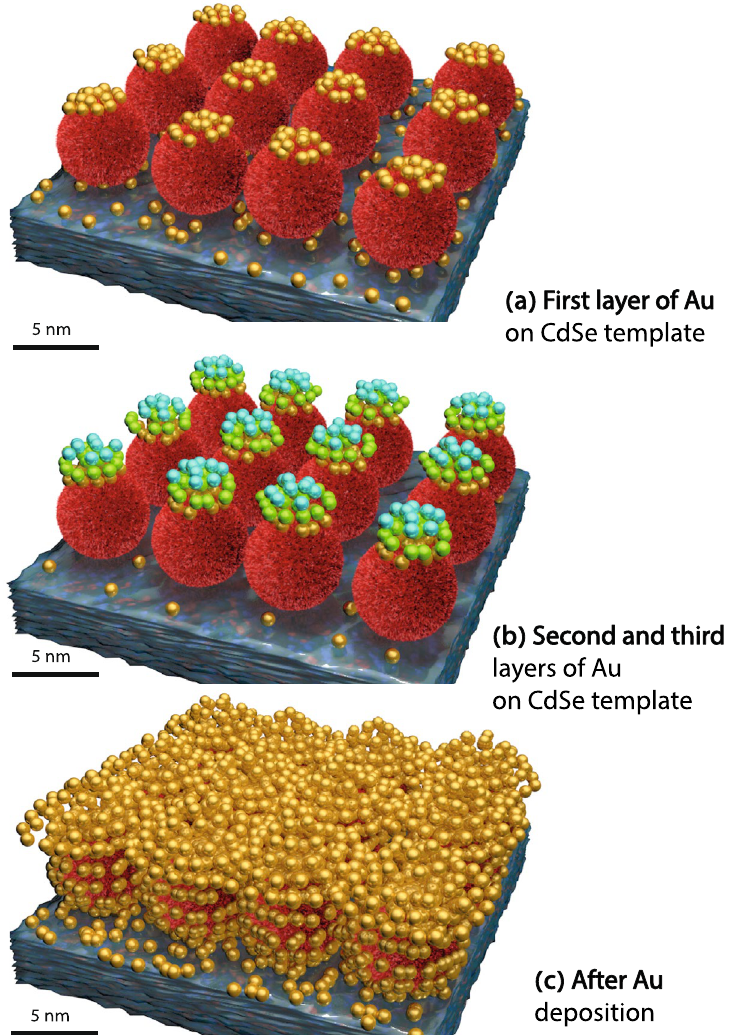
Figure 8. Diagrammatic sketch of Au nanostructure growth on QD arrays template depicting the case of dithiol , in particular: ( a ) template-mediated nucleation of Au on top of the QDs forming the first monolayer. ( b ) Dissociated partial coverage of the nucleation site and subsequent growth of Au nanostructures on top of the first monolayer. ( c ) Au coverage after a certain duration of in situ sputtering. We have used different shades for the Au on top of CdSe (red) than the adjacent ones for the first monolayer (golden) as also for the second monolayer (light green) and the third monolayer (cyan). This is to justifiably visualize the thickness dependent lateral correlation of the